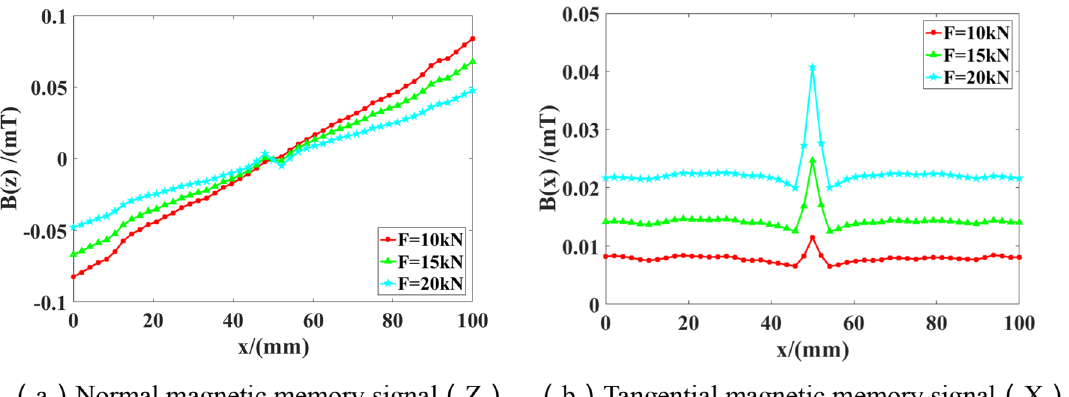
Fig. 7 Magnetic memory signal changes in geomagnetic field under different tensile forces of longitudinal cracks. a Normal magnetic mem- ory signal (Z). b Tangential magnetic memory signal (X)